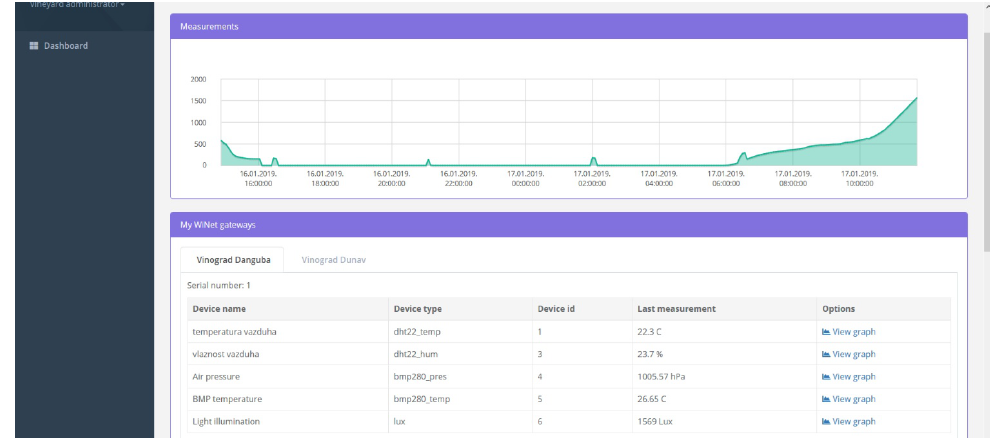
Figure 11. The Winet Web application—measurement graph.